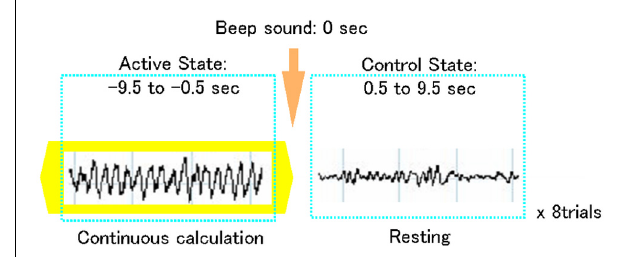
FIGURE 1 | Schematic representation of an MEG trial using a focused attention paradigm. Each trial included a 10-s frontal midline theta activity during focused attention on mental calculation (active state) followed by a 10-s non-arithmetic period (control